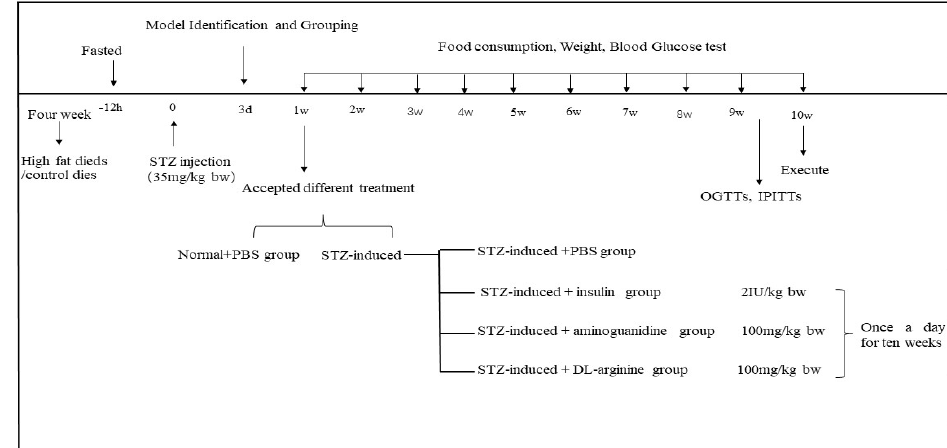
Scheme 1. Time point of different treatments of animal